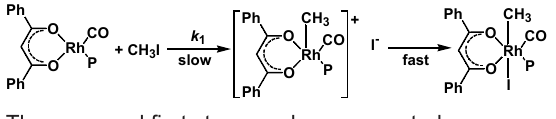
-orbital at the methyl group of the TS LUMO diagram. The colour code (online version) of the atoms z